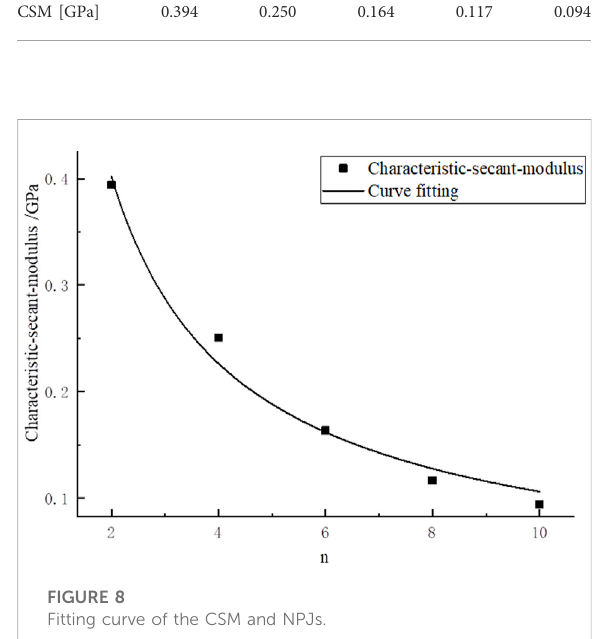
FIGURE 7 Fitting curve between CSSM and NPJs.